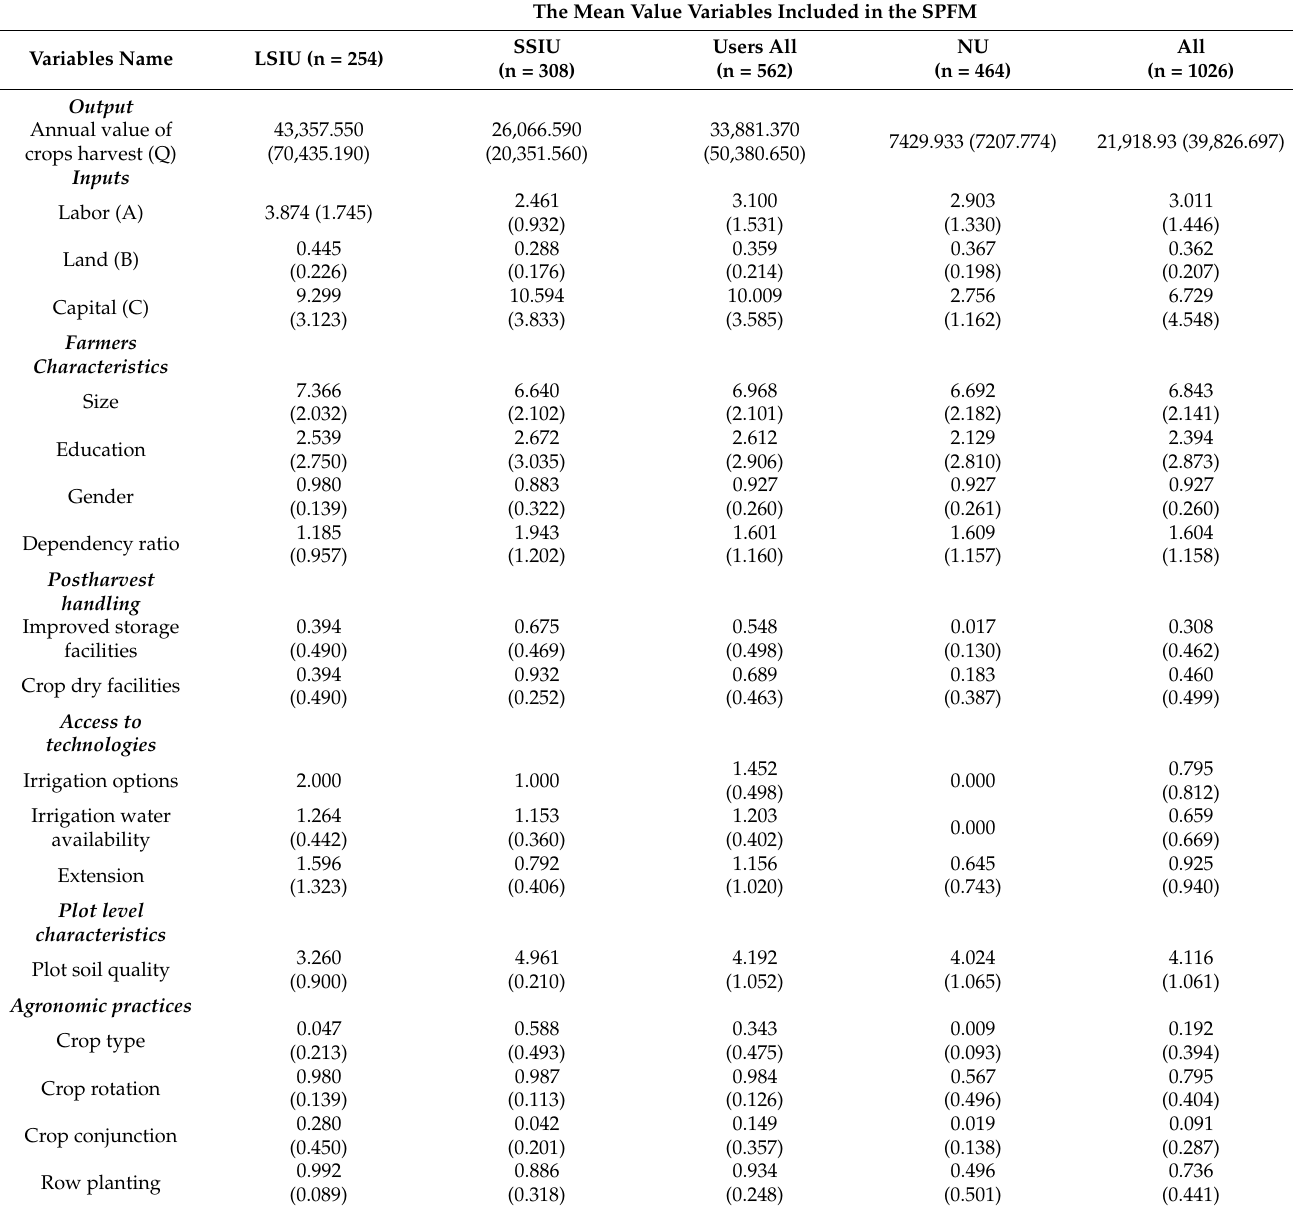
Table A1. Descriptive statistics.